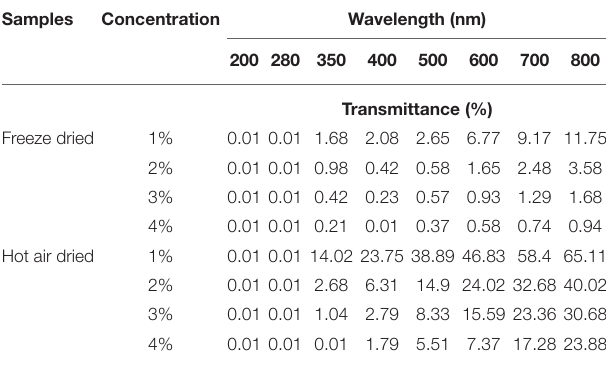
TABLE 2 | Texture profile analysis of freeze dried and hot air-dried gelatin. Characteristics